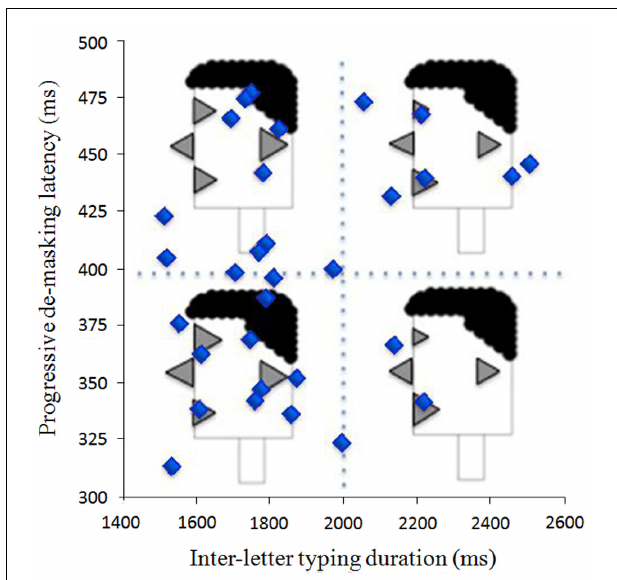
FIGURE 10 | Using facial profiles to code average values within a quadrant of graph space.